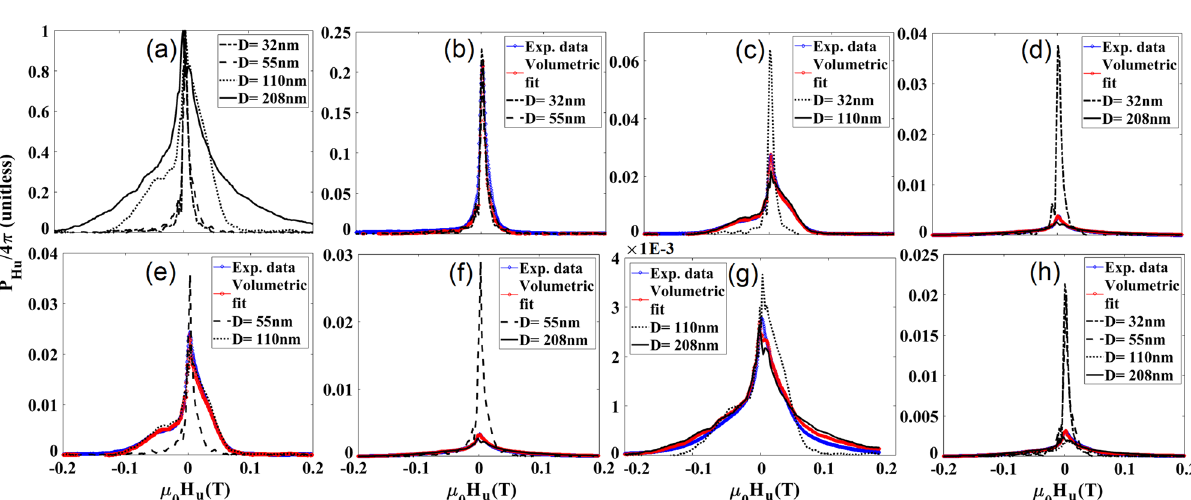
Figure 4. Interaction distribution (P Hu , the integral over H c from the FORC heat-maps) for ( a ) normalized for individual types of MNWs, ( b – g ) different combinations of two types of MNWs, as indicated in the legend and ( h ) one combination of four types . The blue lines show measurements of combinations, and the red lines show the best match for combinations of the individual signatures (from a ) using volume ratio, see Table